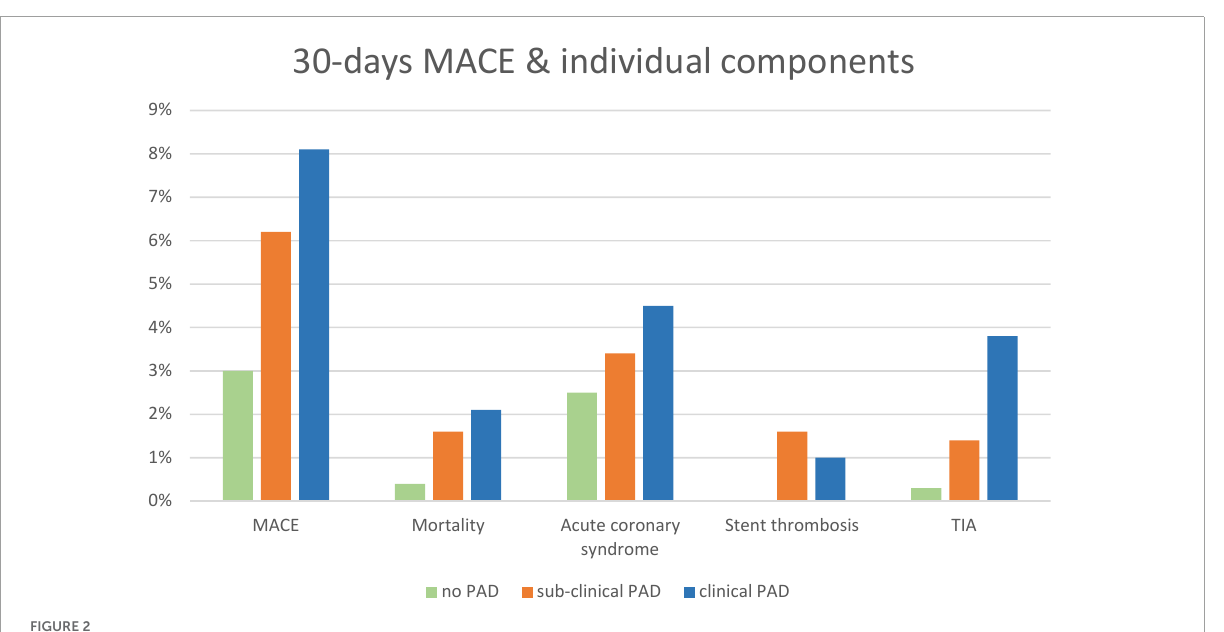
Frontiers in Cardiovascular